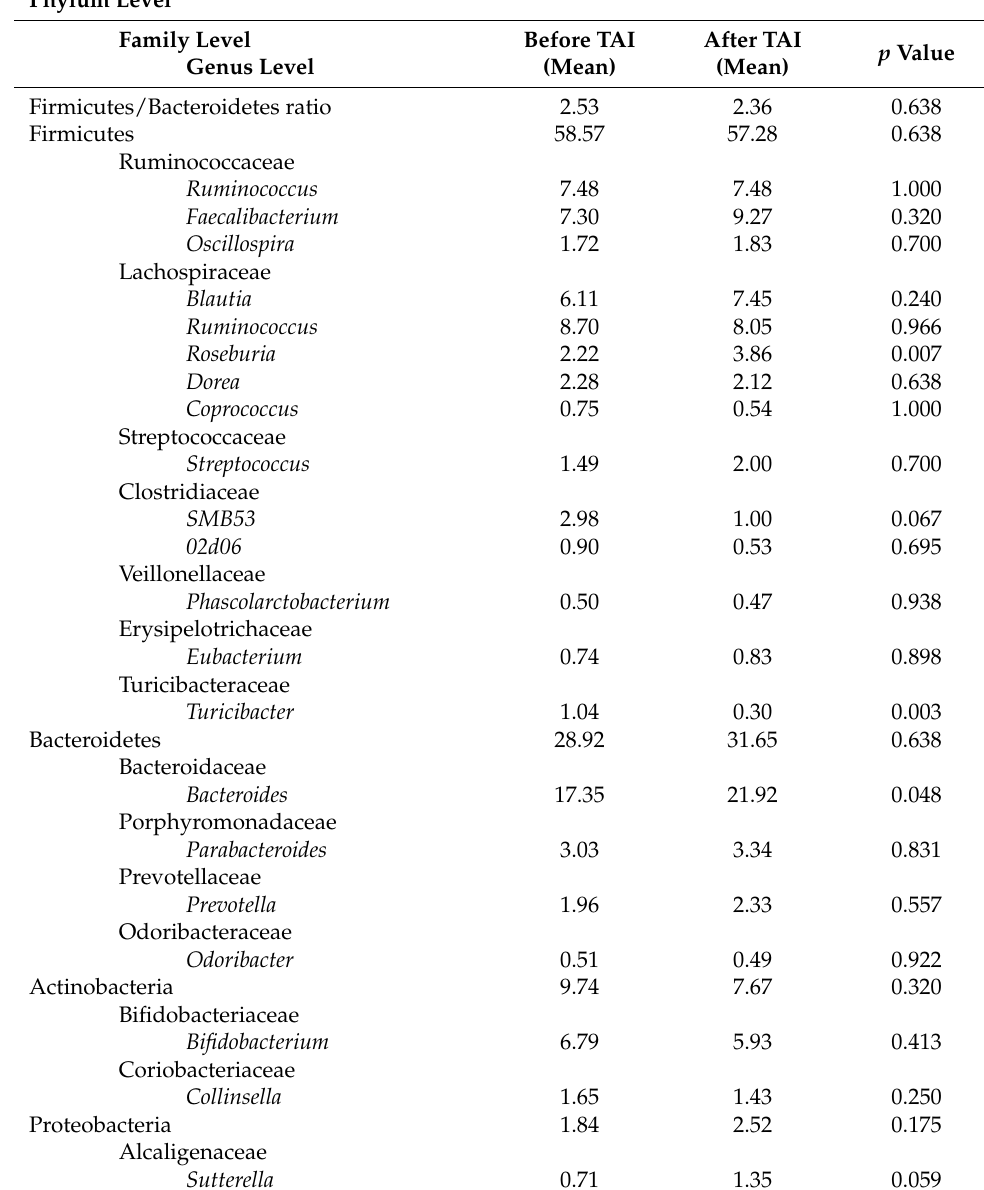
Table 4. Changes in gut microbiota after TAI in the SB patients.